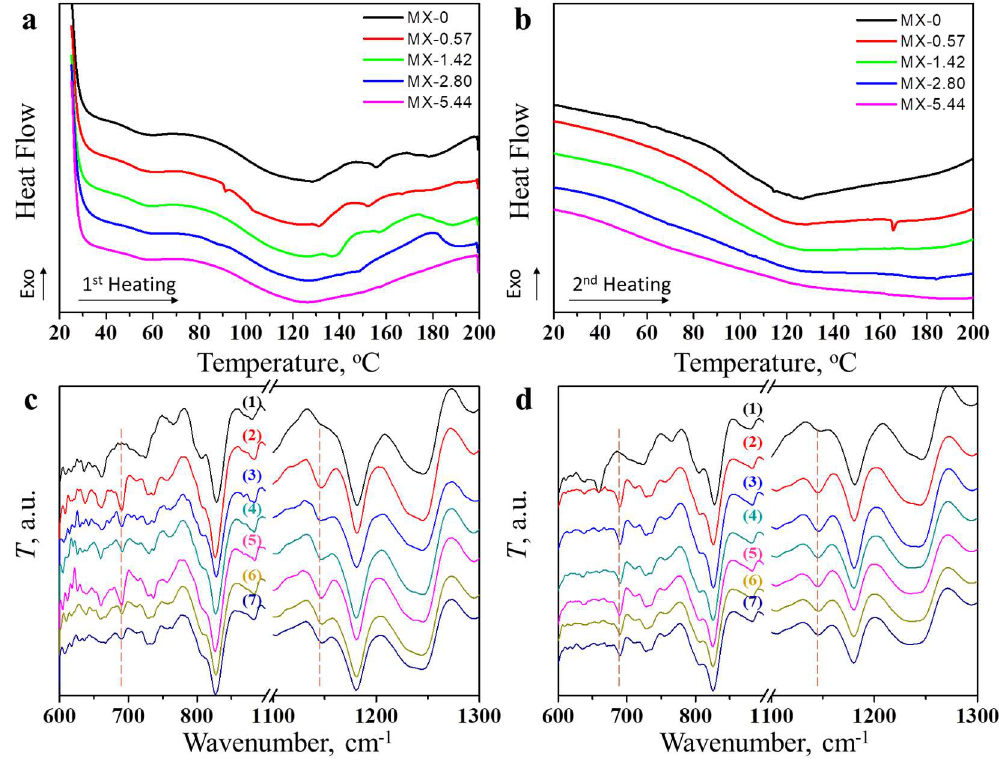
Figure 3. DSC heating curves of MX-0–MX-5.44: ( a ) first heating; ( b ) second heating; FTIR curves of ( c ) MX-2.80 and ( d ) MX-5.44 after different treatment: (1) after preparation; (2) heating at 150 °C for 10 min; (3) annealing at 60 °C for 1 h; (4) annealing at 60 °C for 2 h; (5) heating at 150 °C for 10 min; (6) annealing at 60 °C for 1 h; (7) annealing at 60 °C for 2 h. The vertical dashed lines indicate the locations of peaks at 696 and 1146 cm −1 .